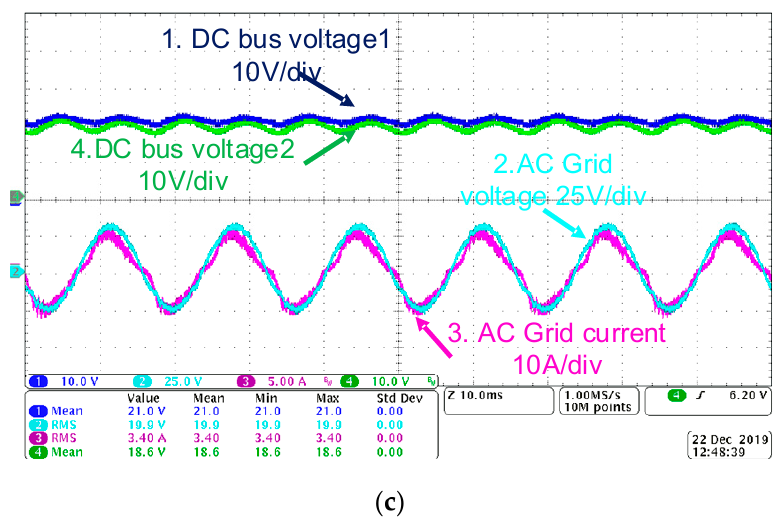
Figure 6. Experimental results for series-connected PFC modules ( a ) without the balancing control; ( b ) with the balancing control and ( c ) Zoom-in view with the balancing control.